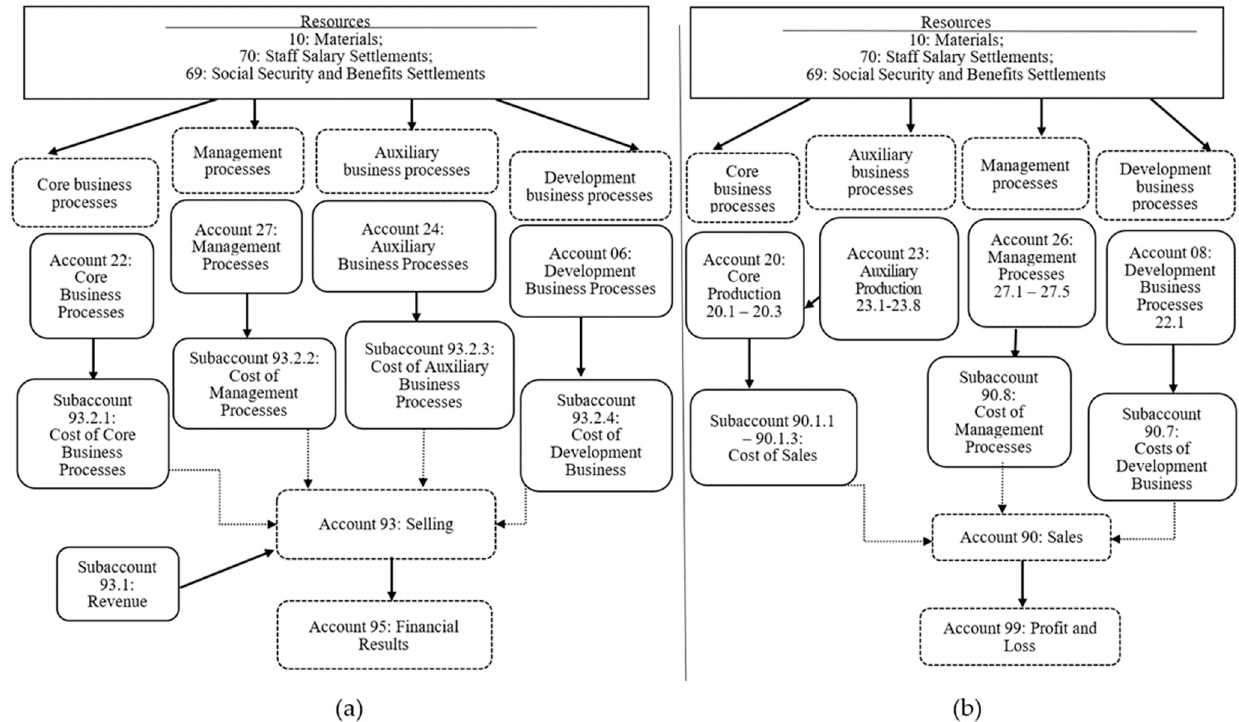
Figure 1. Model of accounting support in the process-based management accounting system: ( a ) Version 1; ( b ) Version 2. Source: authors’ development.